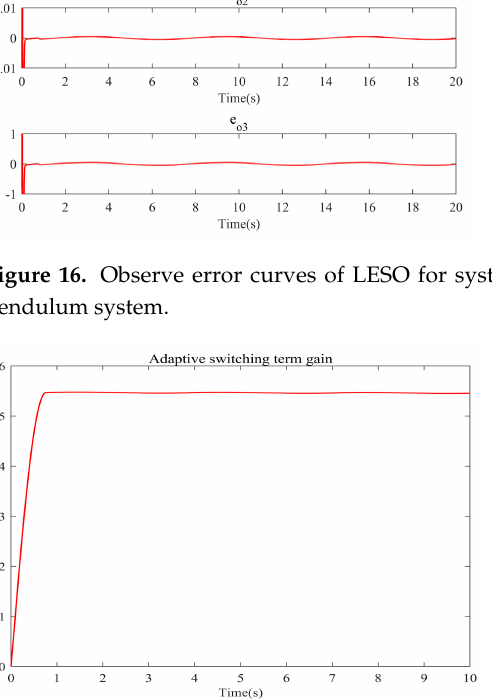
Figure 17. Adaptive curve of switching term gain of ASMC in the inverted pendulum system.